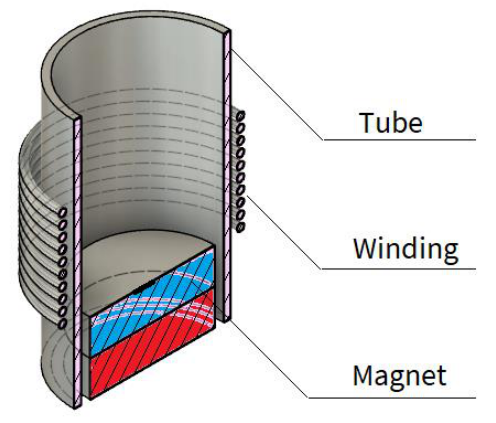
Figure 3. Structure of linear electromagnetic energy harvester.